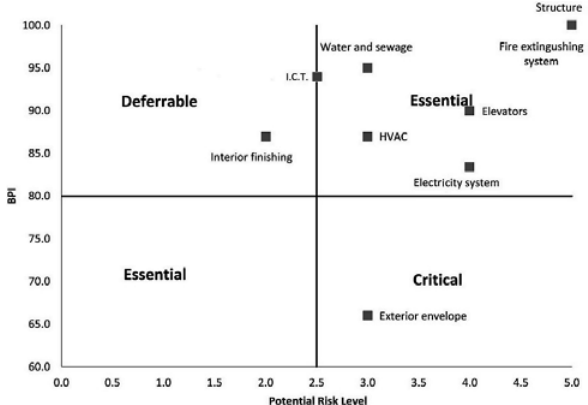
Fig. 9. Boston quadrant matrix of the systems of the case